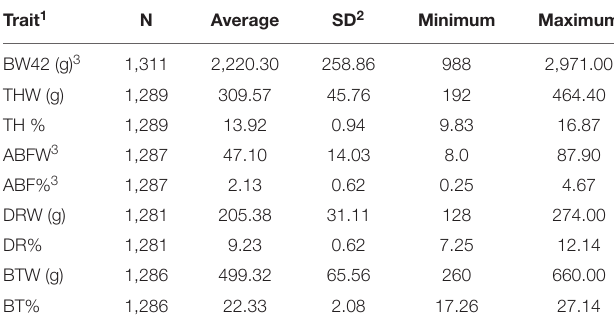
TABLE 1 | Number of animals (N), mean, standard deviation (SD), minimum and maximum values for carcass traits from animals utilized for GWAS analysis in the TT Reference population.